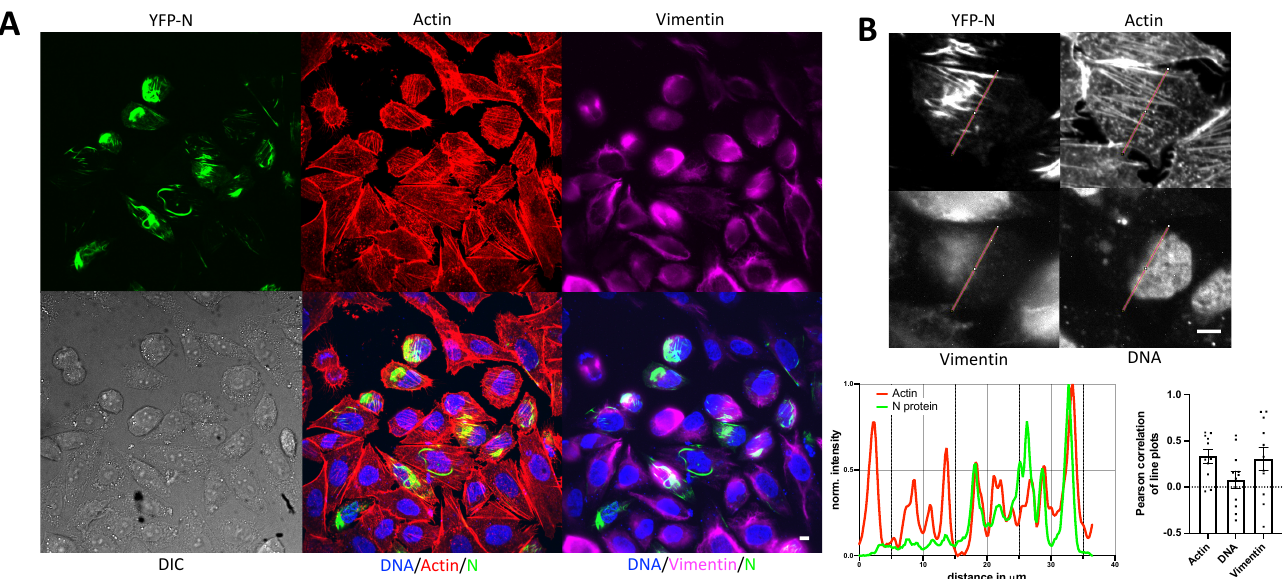
Figure 2. YFP-N co-localizes with cellular actin and vimentin. ( A ) CHO-K1 cells were transfected with YFP-N and stained 24–48 h p.t. for actin using Rhodamine-Phalloidin and vimentin by im- munofluorescence. ( B ) Line-plot analysis of individual cells reveals marked co-localization of YFP-N and actin filaments as well as vimentin. The panel shows one representative cell and the correspond- ing line plots from all fluorescence channels after normalization. The bar chart on the lower right shows a quantitative analysis of line plots from multiple cells ( n > 10). Pair-wise Pearson correlations of line plots were calculated for YFP-N with the cellular markers as stated in the bar chart. Bars show mean with SEM. Additional examples can be found in the SI. All images show maximum intensity projections of z-stacks. Scale bars: 10 µ